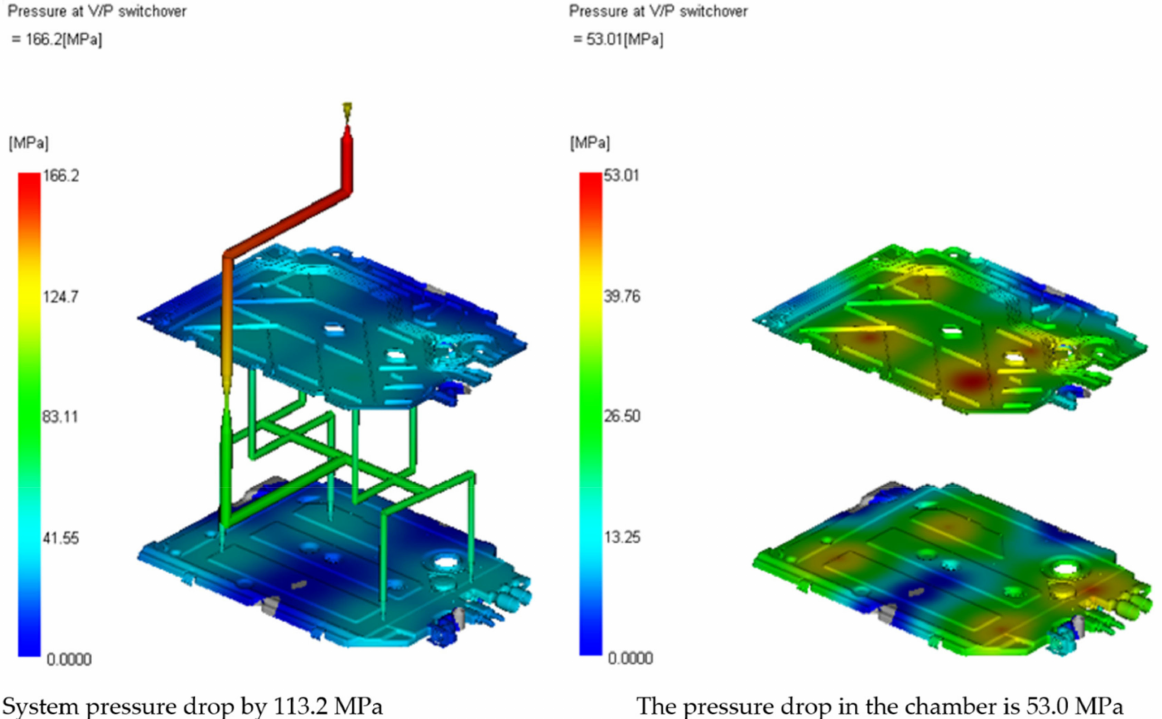
Figure 13. Image of pressure distribution in the seat at the time of filling of